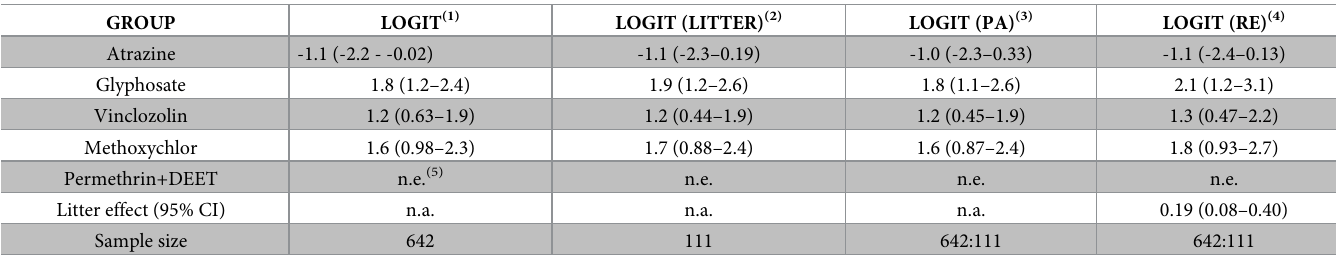
Table 4. Obese: F3 Treatment Effects (95%